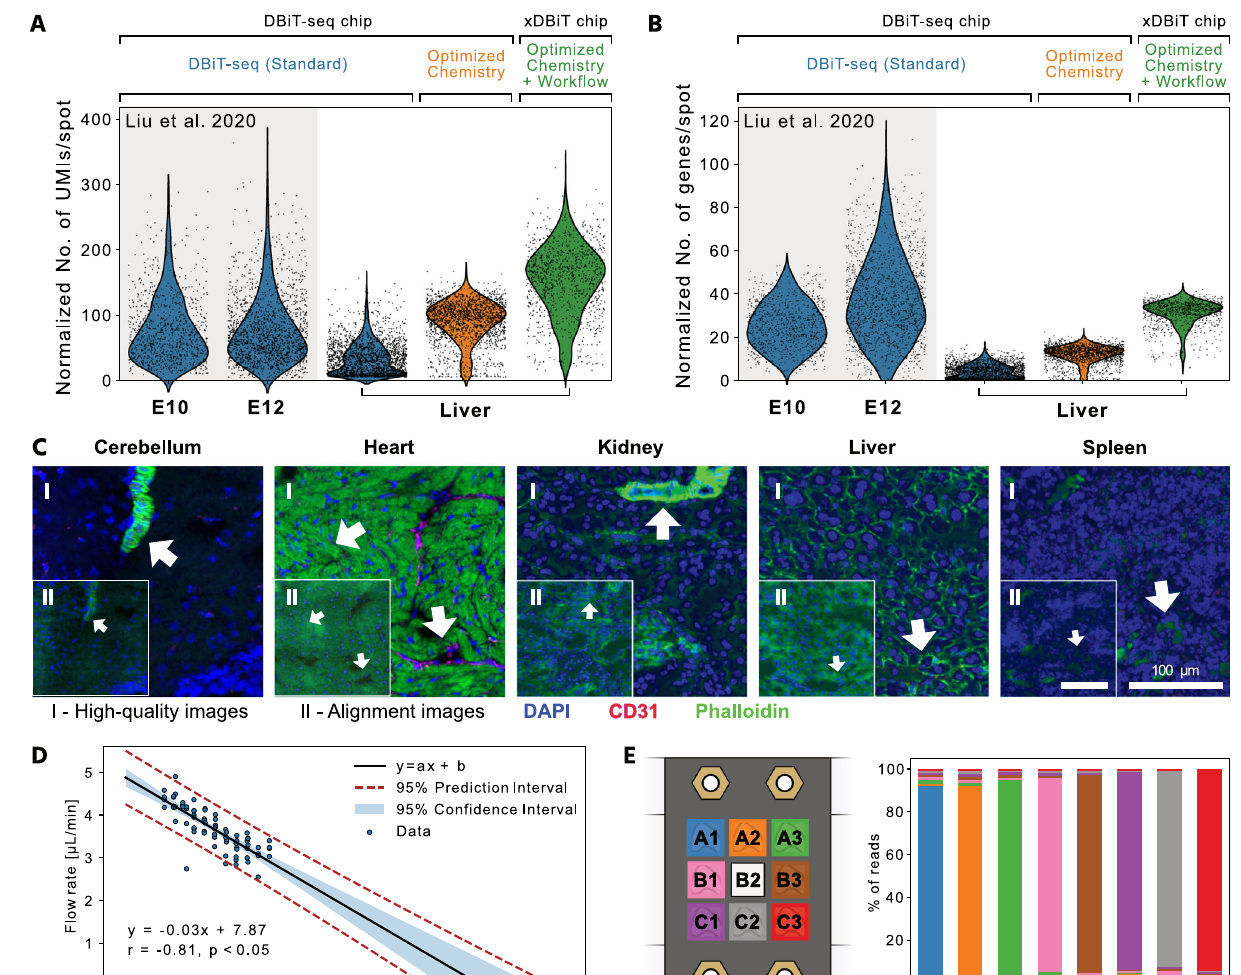
Fig. 2 | Performance of xDBiT and quality assessment of the imaging data. A , B Violin plots showing the number of UMIs A and genes B per 50 µ m×50 µ m spot, normalized to the sequencing depth (per 10 6 reads) of the respective experiment. The xDBiT method was obtained by sequential optimization of the chemical protocol and work fl ow of the DBiT-seq method (Standard). For compar- ison, counts from the previously published DBiT-seq datasets from fresh frozen sections of murine embryos at stage E10 and E12 were added 16 . C Representative high-quality (I) and alignment images (II) of mouse tissue sections acquiredduring xDBiT work fl ow. Blue, magenta, and green colors denote DAPI, CD31, and phal- loidin fl uorescence signals, respectively. The quality of the fl uorescence signal decreases during the xDBiT work fl ow, which demonstrated the need for the initial high-quality imaging round. Each organ has been measured between two and four times, showing similar results. For a detailed overview on the experiments see